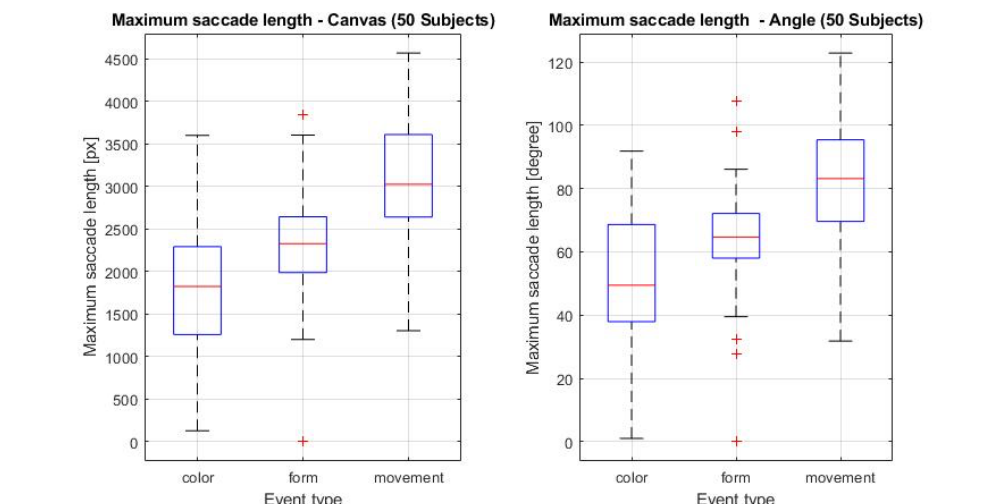
Figure 15: Length of the maximum saccade amplitude towards the feature corresponding to the object change in pixel and degree respectively.